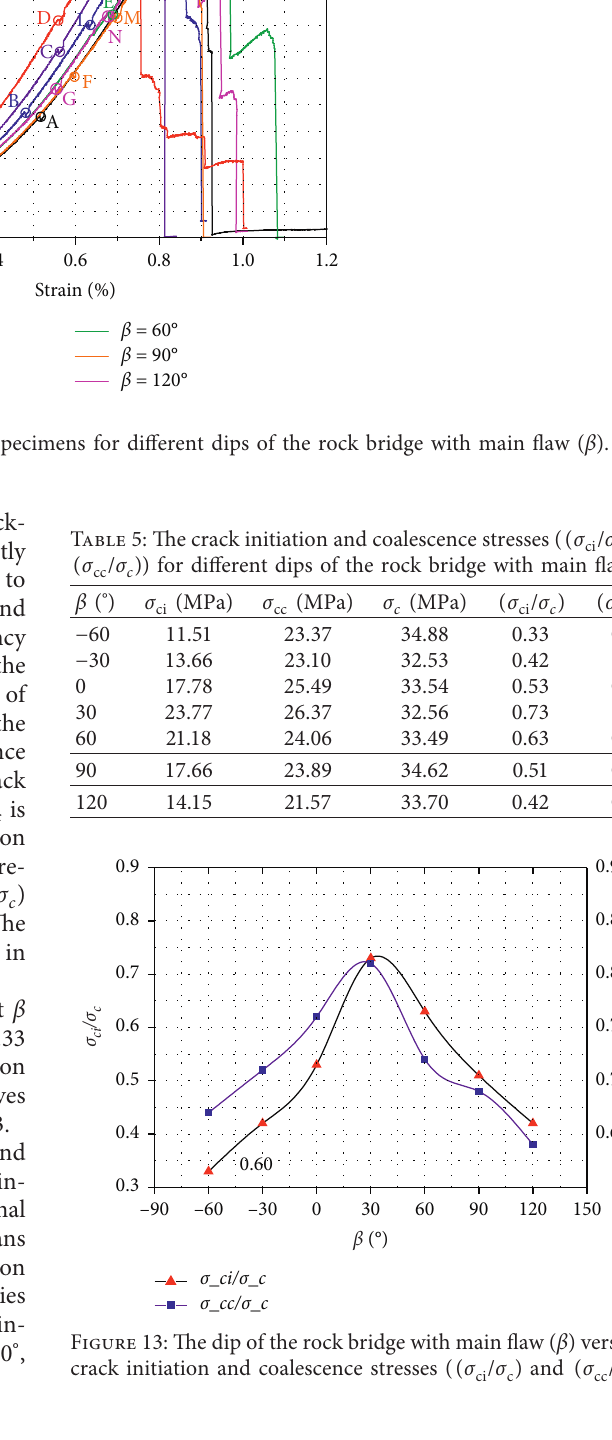
) and ( σ / σ / σ c ) ci c cc